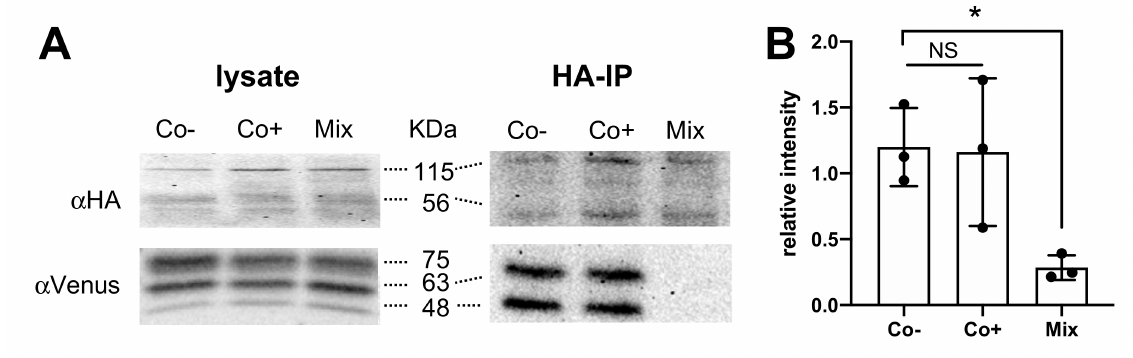
Figure 5. Detection of physical interaction between H 4 R and TSPAN4 in HEK293T cells using co-immunoprecipitation. ( A ) HEK293T cells transiently co-expressing HA-H 4 R and mVenus-TSPAN4 were collected and solubilized upon stimulation with vehicle (Co-) or 10 µ M histamine (Co+), whereas cells expressing either HA-H 4 R or mVenus-TSPAN4 were collected and mixed (Mix; 1:1) before solubilization. Lysates were immunoprecipitated (IP) using anti-HA agarose beads and both lysates and IP samples were resolved by SDS-PAGE and immunoblotted using anti-HA (top panel) or anti-Venus (bottom panel) antibodies. Immunoblots are representative of three independent experiments. ( B ) Densitometric analysis (mean ± SEM) of mVenus-TSPAN4 immunoblots by dividing the intensity of co-immunoprecipitated (IP) mVenus (indicated as 48 KDa and 63 KDa) by lysis mVenus (indicated 48 KDa, 63 KDa, and 75 KDa) intensity from three independent experiments using ImageJ software (National Institutes of Health, Bethesda, MD, USA). Statistical difference versus Co- was analyzed using one-way ANOVA followed by Dunnett’s multiple comparison test and indicated by an asterisk p < 0.05. NS = no significant